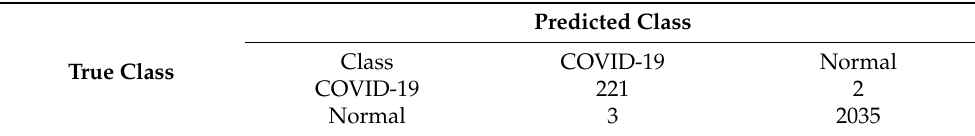
Confusion matrix attained by ShuffleNet in binary classification scheme using chest